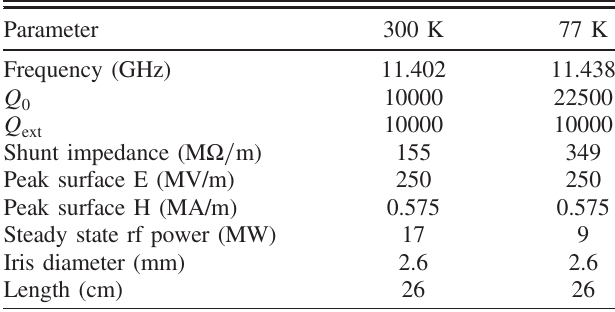
distributed-coupling accelerating structure at 300 and 77 K.